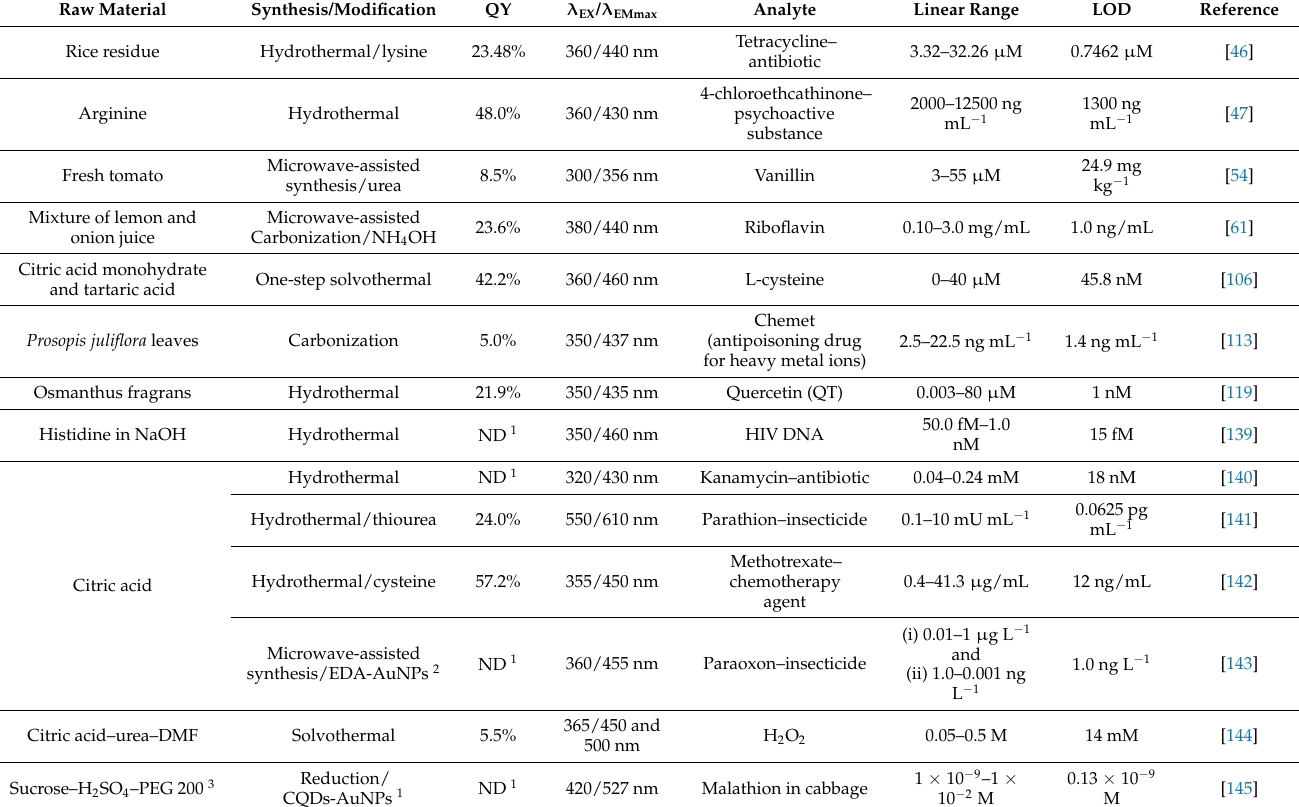
Table 6. CQDs prepared from different carbon sources and their application in molecules